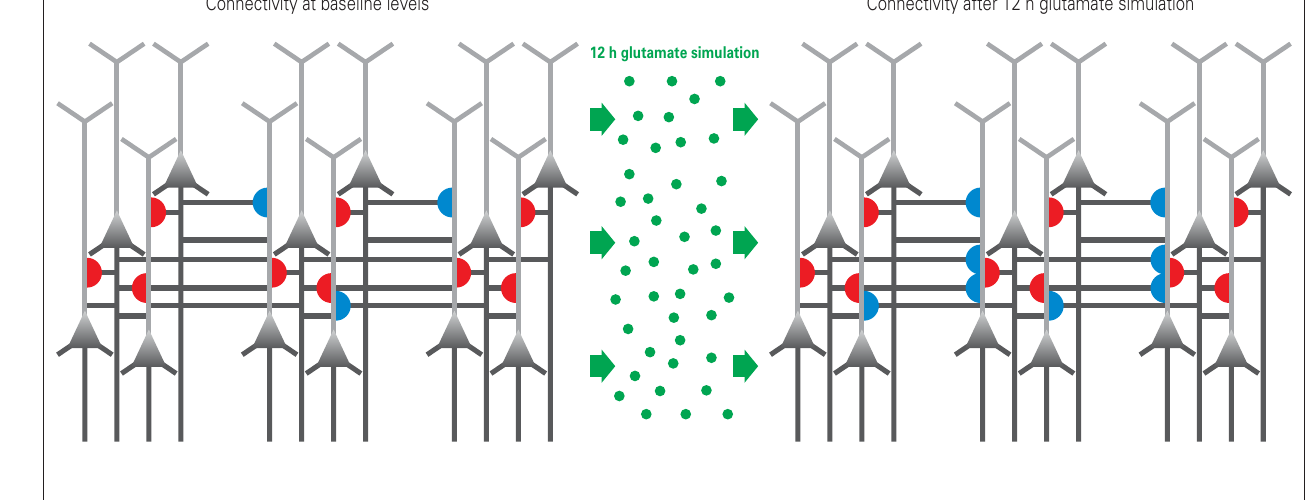
increased within the short mini-columnar range (below 50 μm, red half-circles) before the glutamate stimulation and did not increase any further after the stimulation (right panel), because the connection capacity was already boosted and probably saturated to a maximum at baseline levels. Indeed, controls only reached a similarly high connectivity probability within the mini-columnar range as VPA-treated offspring already exhibited at baseline levels after the 12 h stimulation was applied. However, in VPA-treated offspring, the connectivity probability increased significantly at ranges above 50 μm (right panel, blue half-circles), revealing a further remarkable rewiring capacity at the columnar range due to stimulation – a feature “normal” control microcircuits did not